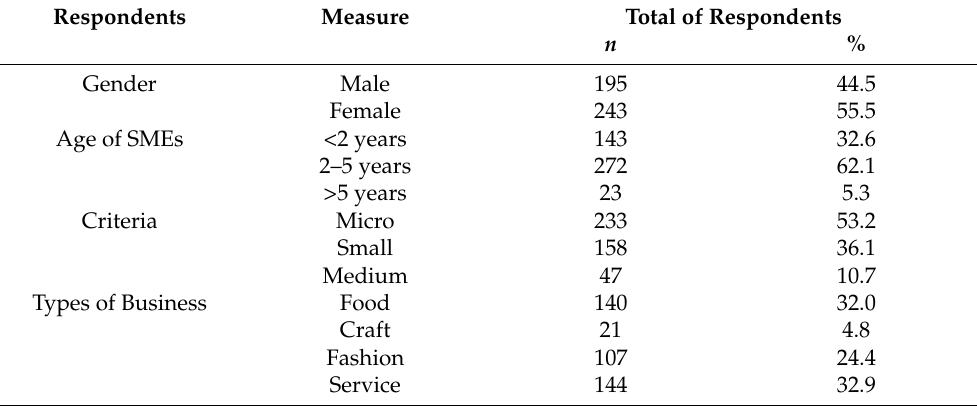
Table 1. Descriptive Statistic of